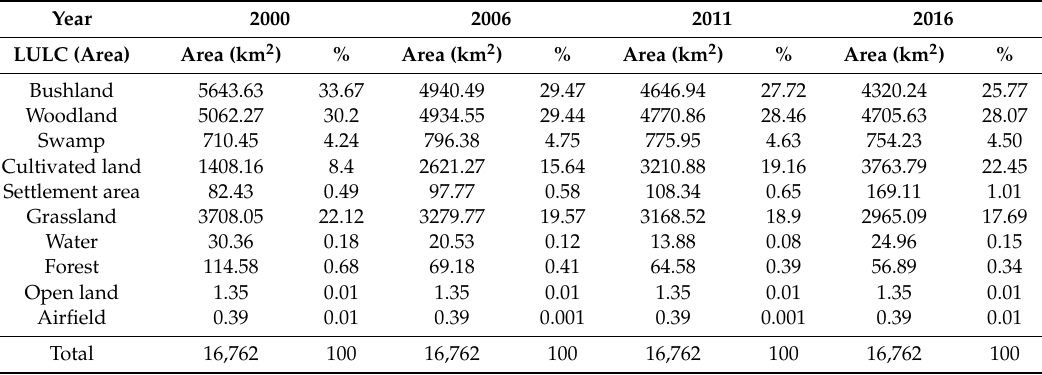
Table 5. Results of the LULC classification for 2000, 2006, 2011, and 2016 images showing the area of each category and category percentages (Kinyasungwe